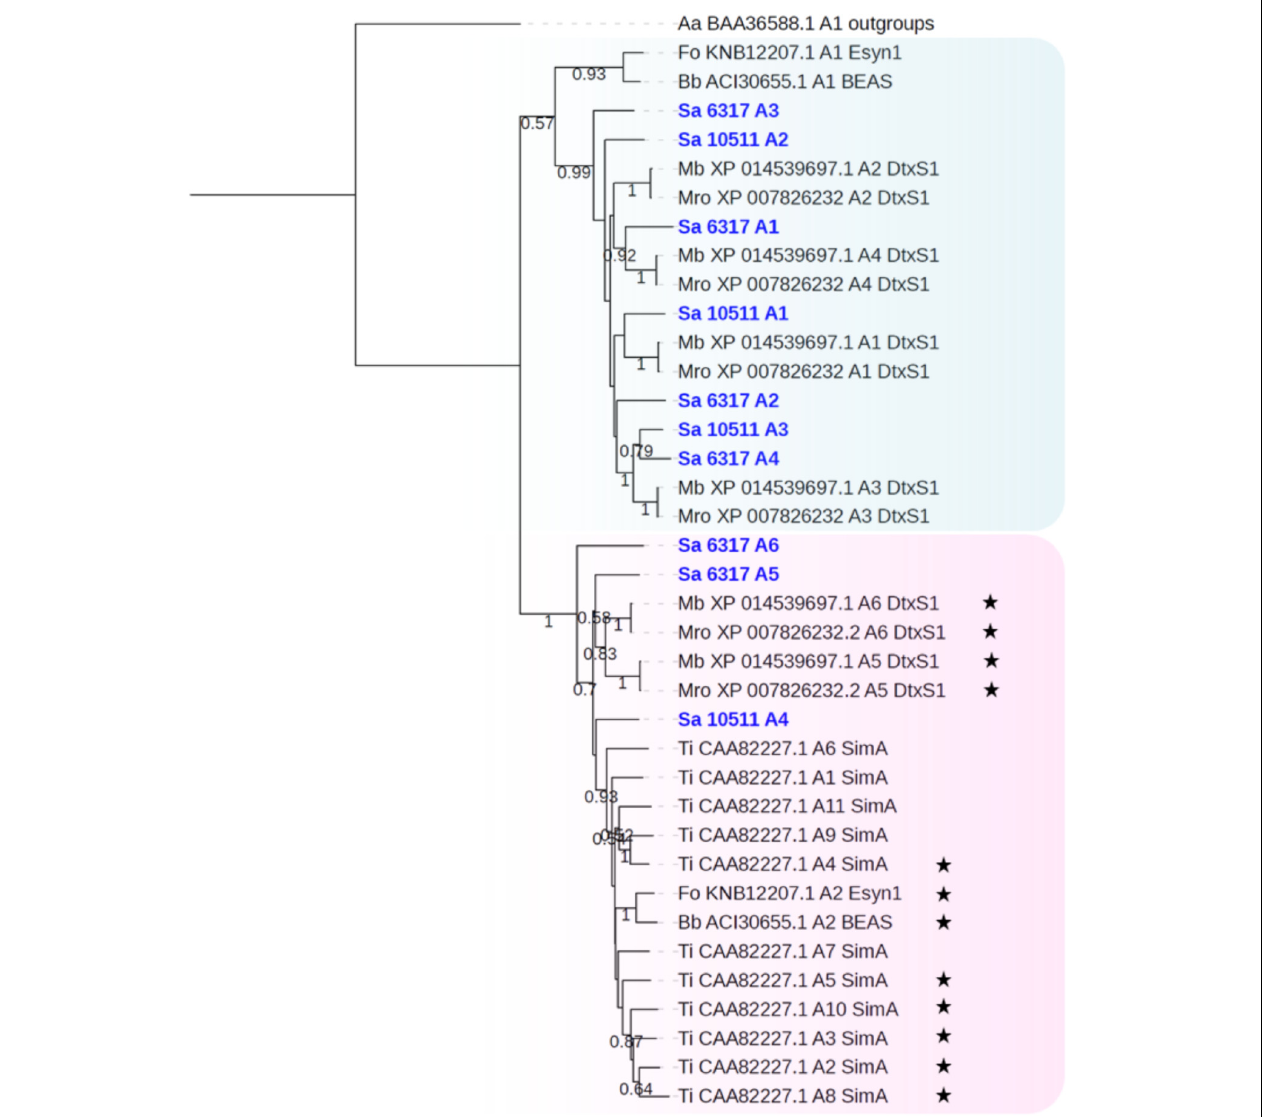
FIGURE 7 | Maximum likelihood phylogenetic tree (PhyML + LG model) of cyclopeptide-producing NRPS generated from an extended A-domain dataset. The first A-domains of the protein coded by SAPIO_CDS6317 (A1–A4) and SAPIO_CDS10511 (A1–A3) group together within a clade also harboring the first four A-domains of DtxS1 from Metarhizium species, while the A5 and A6 domains of SAPIO_CDS6317 and the A4 domain of SAPIO_CDS10511 form another clade harboring the last A-domain(s) of NRPS producing cyclohexapeptides, as well as the eleven A-domains of the cyclosporine synthase (SimA). Black stars symbolize A-domains that incorporate N-methylated amino acids into the peptide chain. Bootstrap support values greater than 50% are reported below branches. All S. apiospermum NRPS A-domains are shown in bold